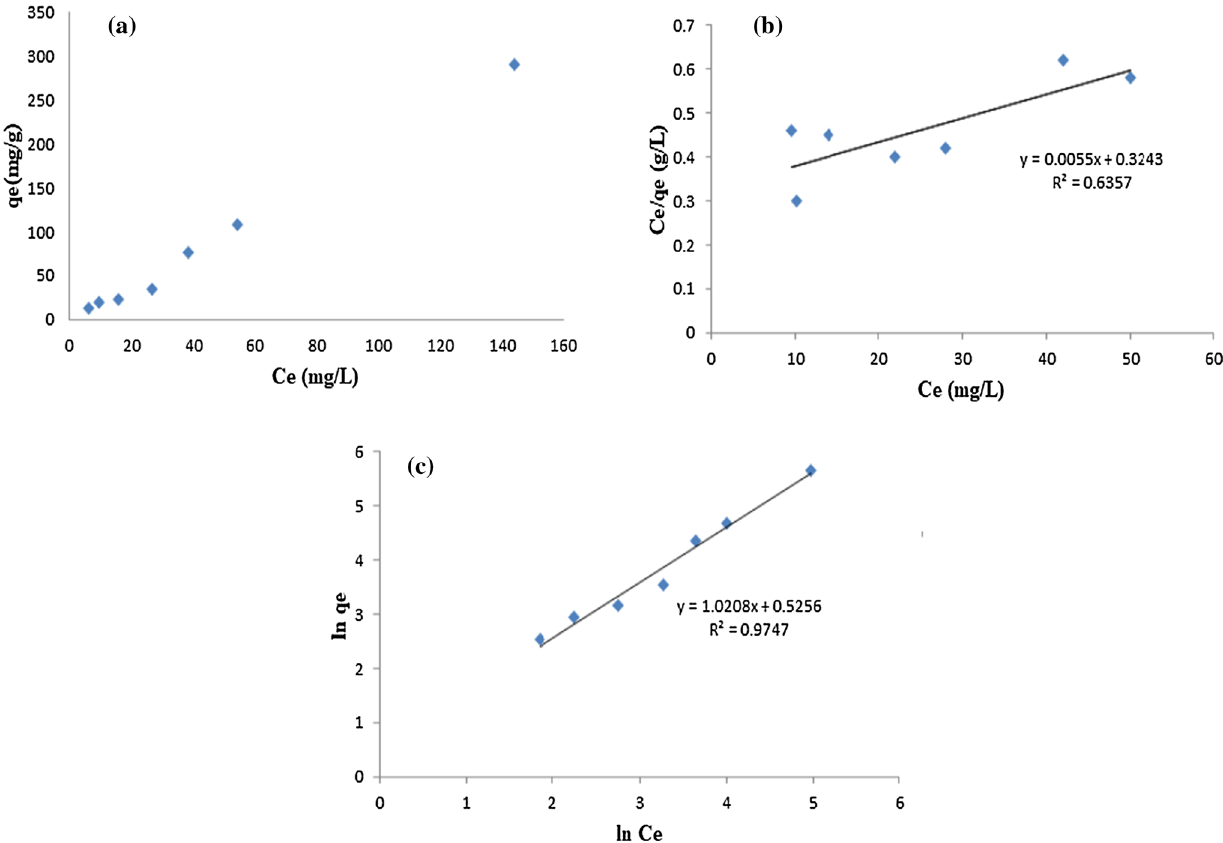
Fig. 1 a Adsorption isotherm, b Langmuir isotherm and c Freundlich isotherm for the adsorption of Co from aqueous solutions on cross-linked